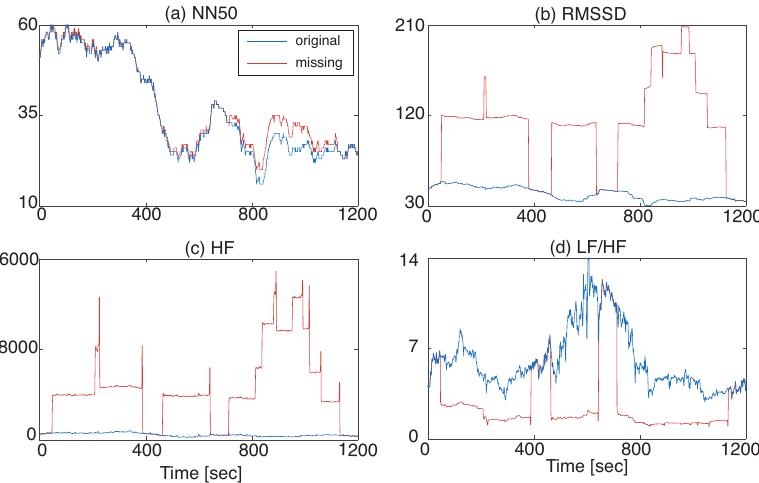
Figure 4. HRV features extracted from the missing RRI: ( a ) NN50, ( b ) RMSSD, ( c ) HF, and ( d ) LF/HF. There were large errors in HRV features due to frequent missing